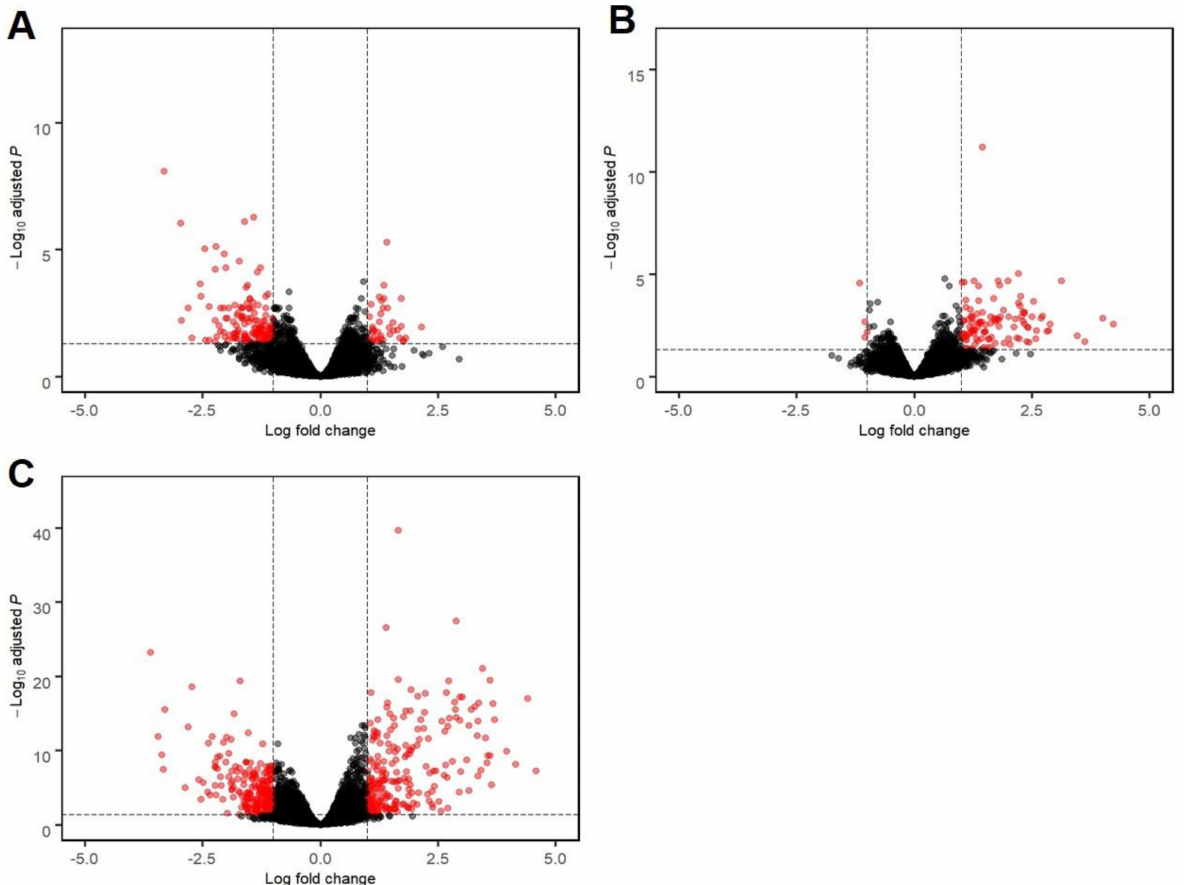
Figure 5. Volcano plots of differentially expressed genes. ( A ) Genes differentially expressed between EHM and non-EHM horses. Genes with a positive log fold change represent genes upregulated in EHM horses compared to non-EHM horses, while genes with a negative log fold change represent genes downregulated in EHM horses compared to non-EHM horses. ( B ) Genes differentially expressed within non-EHM horses. Genes with a positive log fold change represent genes upregulated in non-EHM horses post CH compared to pre CH, while genes with a negative log fold change represent genes downregulated. ( C ) Genes differentially expressed within EHM horses. Genes with a positive log fold change represent genes upregulated in EHM horses post CH compared to pre CH, while genes with a negative log fold change represent downregulated genes. p values are expressed on the y -axis, with more significantly differentially expressed genes towards the top of the plot. Genes highlighted in red passed the threshold of significance set at adjusted p -value < 0.05 and log fold change